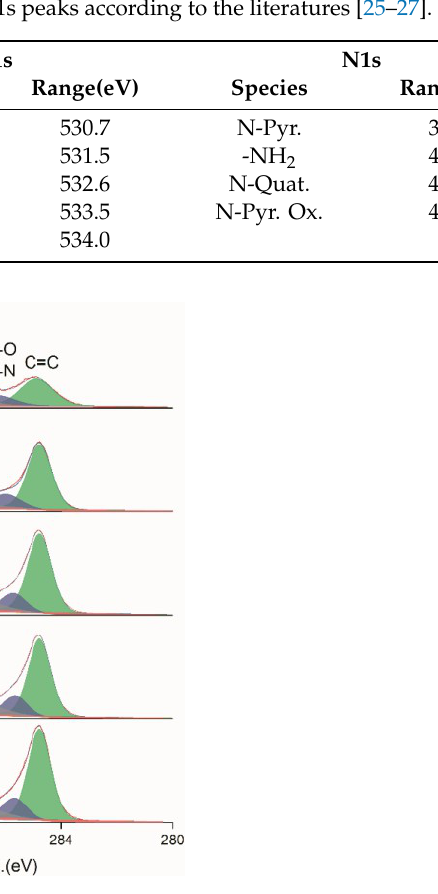
Table 2. Assignments of the O1s, C1s, and N1s peaks according to the literatures [25–27].